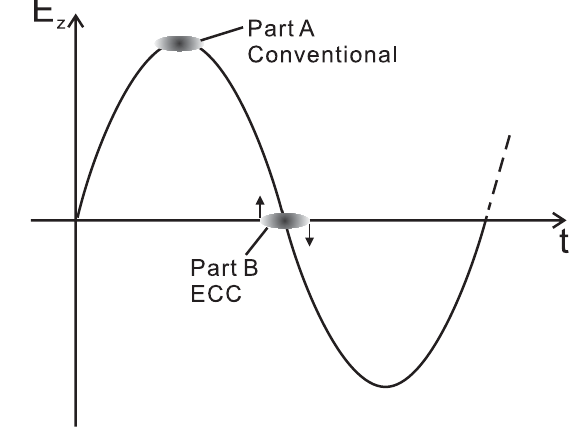
FIG. 1. Schematic of rf electron gun. FIG. 2. Bunch acceleration by rf electric